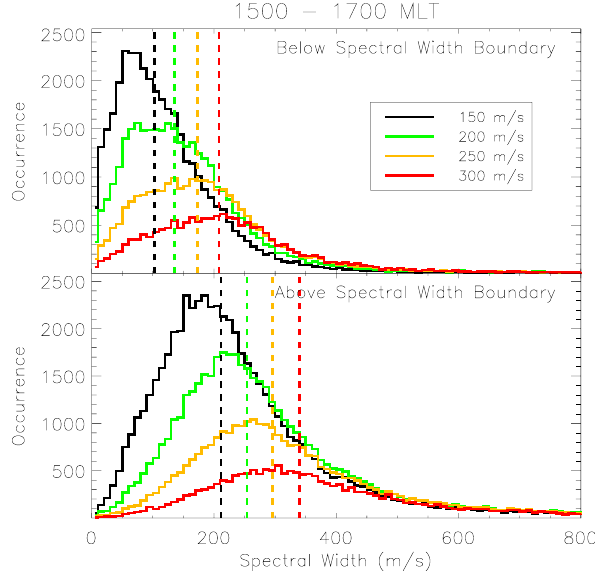
Fig. 8. The distribution of spectral width values below (equatorward of) and above (poleward of) the spectral width boundary determined by applying the C-F threshold technique to 5-years worth of spectral width data from beam 8 of the Halley SuperDARN radar. Only data from the 15:00–17:00 MLT region, and from within 10 range gates of the estimated boundary location, are shown. The four different histograms represent the results from using four different spectral width threshold values (150, 200, 250, and 300m/s) to identify the